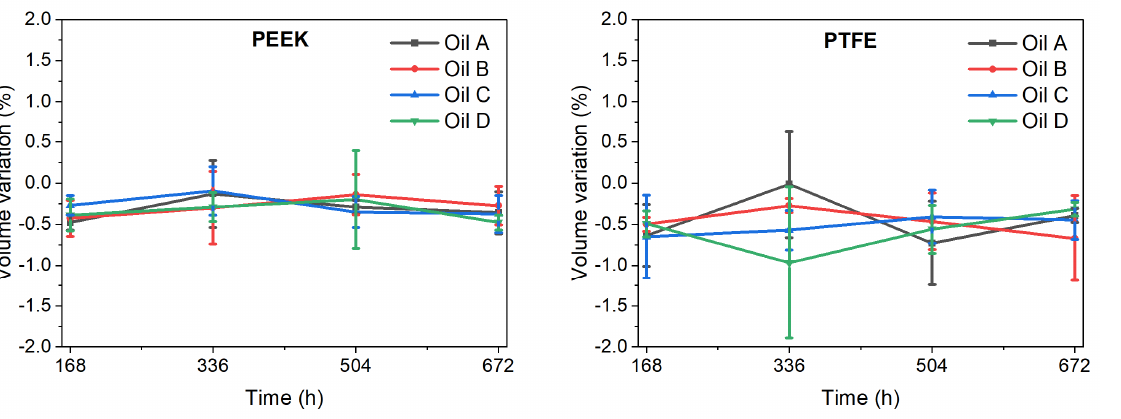
Figure 1. Changes in volume of PEEK, PA66, and PTFE after immersion in oils A, B, C and D. After longer ageing times (from 168 h upwards), PEEK and PA66 hardly changed in volume. The volume variations remained, in general, between 0 and − 1%. On the other hand, PTFE showed greater volume variations than its counterparts. Although there are no specifications for these materials when aged in ATFs regarding the admissible changes in volume, it could be concluded that all the materials underwent negligible volume changes. These changes were negligible, not only during the time established in the standardised test, but also for longer time periods. 3.2. Changes in Hardness In a similar way to the volume variation tests, there are no specifications for changes in the hardness of polymers aged in ATFs. In general, only small changes in hardness were measured after the first 168 h in the three tested materials (Figure 2). Since the hardness of PEEK and PTFE decreased by around 3 points (Shore D), PA66 was the only material that hardened a little after ageing. The changes in hardness of every material were similar, irrespective of the oil used. From 168 h upwards, the materials showed negligible variation in hardness, which leads us to the conclusion that they are compatible with the ATFs in the tests.